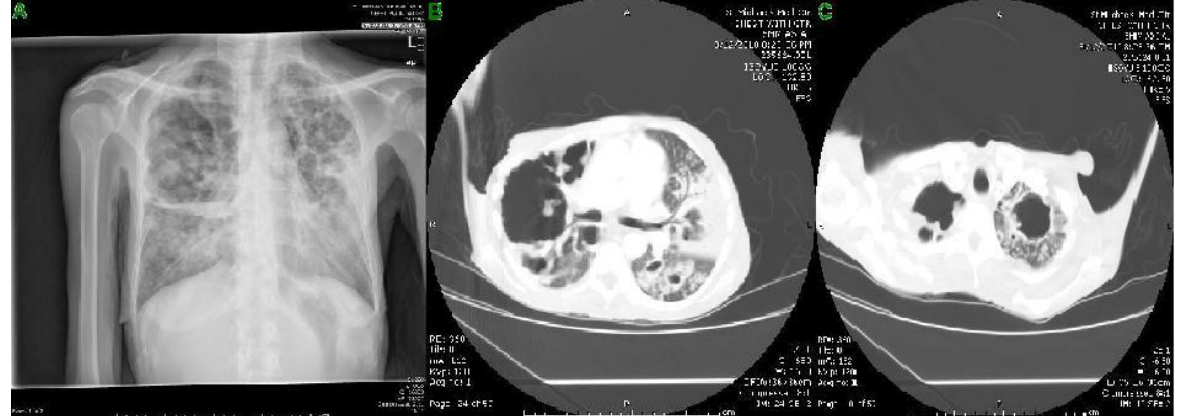
FIGURE 1. (A) Chest X-ray of the patient showing bilateral cystic and bullous infiltrates, and (B, C) CT scans of the chest showing a large cavitary lesion in the right upper